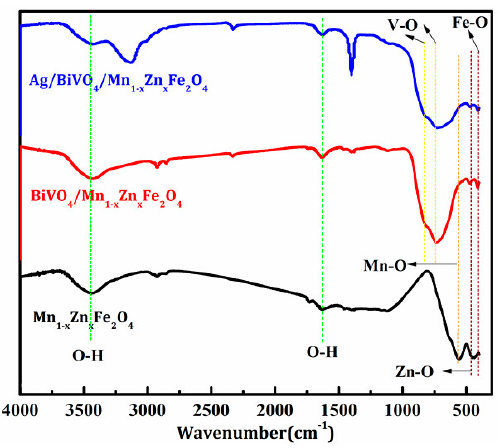
Figure 2. FTIR spectra of Mn 1 − x Zn x Fe 2 O 4 , BiVO 4 /Mn 1 − x Zn x Fe 2 O 4 , and Ag/BiVO 4 /Mn 1 − x Zn x Fe 2 O 4. To discern the element contents in Ag/BiVO 4 /Mn 1 − x Zn x Fe 2 O 4 and determine their valence states, XPS study was carried out. The binding energy peaks of Ag, O, V, Bi, Fe, Zn, and Mn were recorded in Figure 3. The peaks of O, V, Bi, Fe, Mn, and Zn elements were clearly observed in Figure 3a. Further comparing the fully scanning XPS spectra, it can be seen that the characteristic profile of Ag3d was obvious in Ag/BiVO 4 /Mn 1 − x Zn x Fe 2 O 4 while Ag peak in BiVO 4 /Mn 1 − x Zn x Fe 2 O 4 was not observed. Thus, it was deduced that the doping Ag in BiVO 4 /Mn 1 − x Zn x Fe 2 O 4 was successful [25]. The peaks at the binding energy of 373.9 eV and 367.9 eV in Figure 3b was severally ascribed to Ag 3d 3/2 and 3d 5/2 [19], revealing the existence of Ag + . In Figure 3c, the peaks of O1s, V2p 3/2 , and V2p 1/2 were located at 530.5 eV, 516.5 eV, and 523.4 eV, which were assigned to O 2 − and V-O bands. There were peaks of Bi4f 5/2 and 4f 7/2 at 164.1 eV and 158.3 eV in Figure 3d, indicating the presence of bismuth species of Bi 3+ in BiVO 4 . Figure 3f displayed peaks at the binding energy of 641.5 eV (Mn2p 3/2 ) and 653.1 eV (Mn2p 1/2 ). The high resolution spectra of Fe2p as well as Zn2p were shown in Figure 3e,g. These peaks verified the presence of Mn 1 − x Zn x Fe 2 O 4 , which was consistent with the results of XRD and FTIR detection [26]. So, Ag/BiVO 4 /Mn 1 − x Zn x Fe 2 O 4 was successfully assembled by in situ wet-chemistry synthesis method. This synthesis approach was simple, low cost, and environmentally friendly.